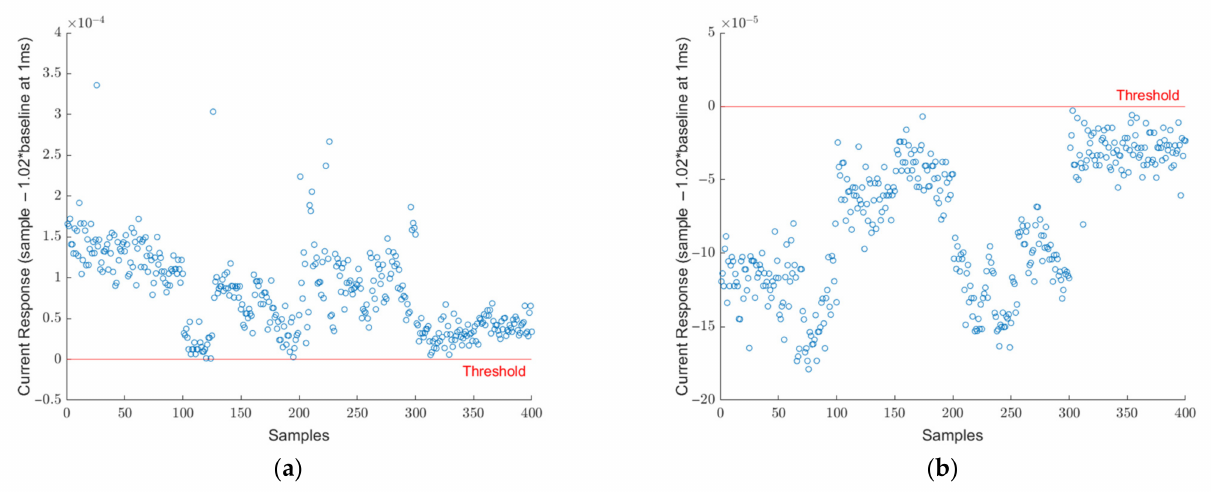
Figure 3. ( a ) Signature analysis of 400 SARS-CoV-2 positive samples. All current response difference points for 400 samples are above the threshold line. Meaning all samples were diagnosed correctly as SARS-CoV-2 positive. ( b ) Signature analysis of 400 blank samples. All current response difference points for 400 samples are below the threshold line. Meaning all samples were diagnosed correctly as SARS-CoV-2 negative.